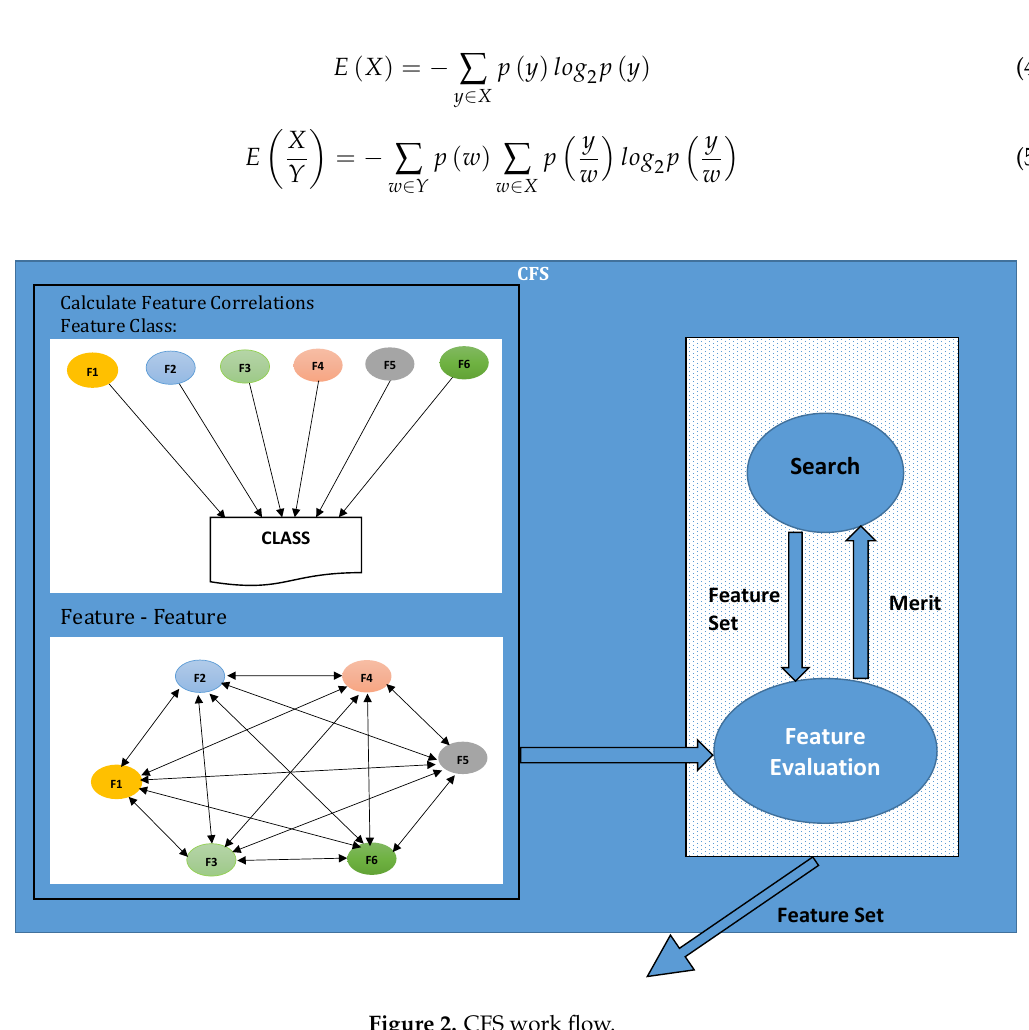
Figure 2. CFS work flow.